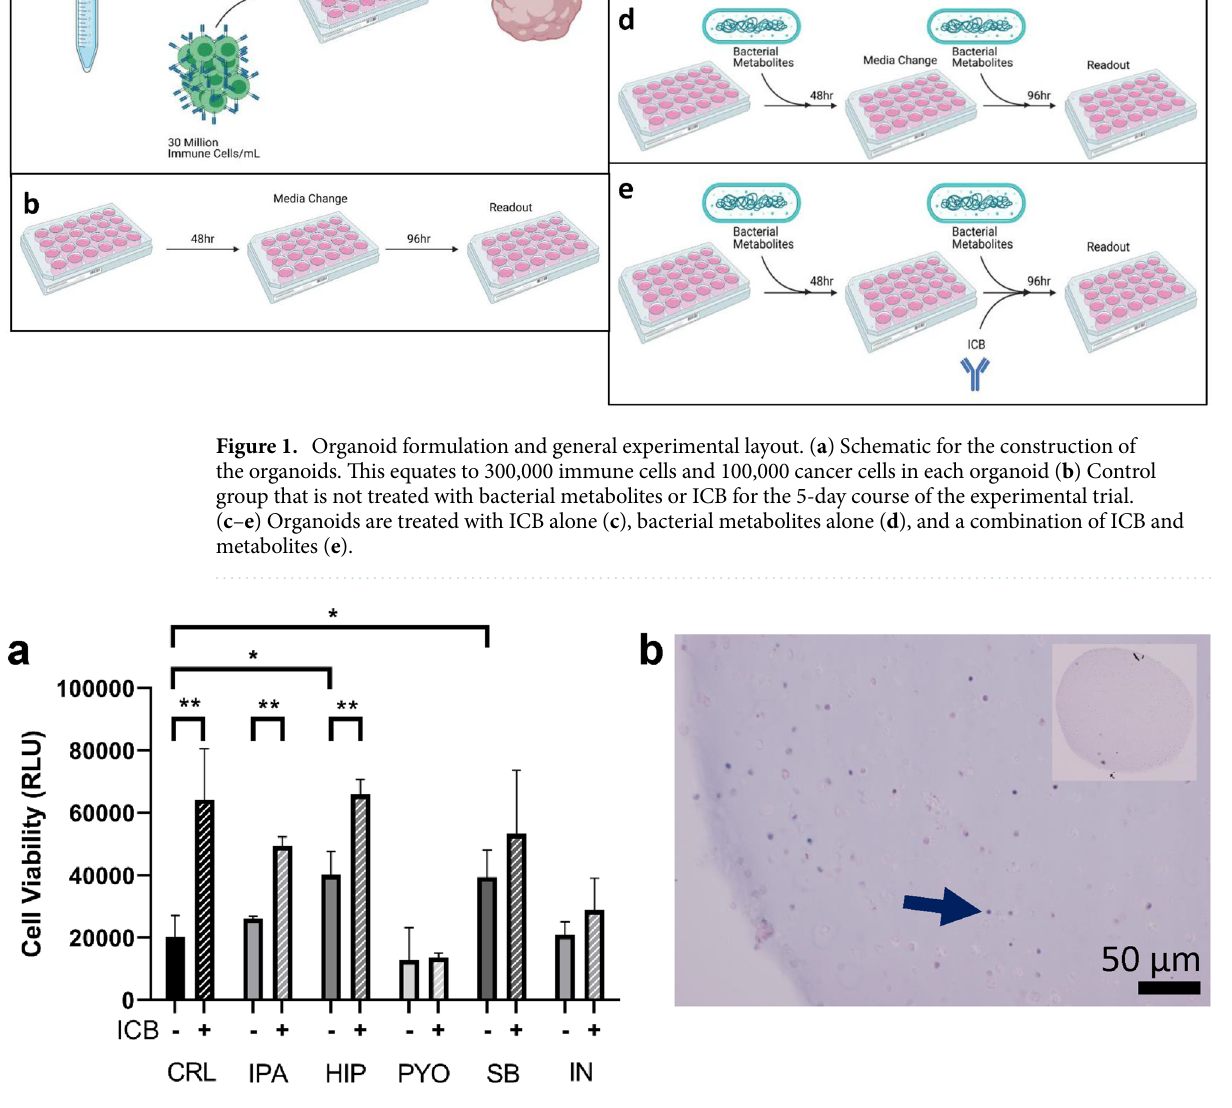
Figure 2. Effect of ICB and bacterial metabolites cell viability in immune cell organoids. ( a ) ATP production was measured via CellTiter-Glo 3D™ for untreated CRL organoids, metabolite treated organoids, ICB treated organoids, and organoids that received a combination of both treatments (n = 4). ( b ) H&E stained splenocytes organoid (arrow indicates splenocyte. 20 × magnification, inset 4 ×